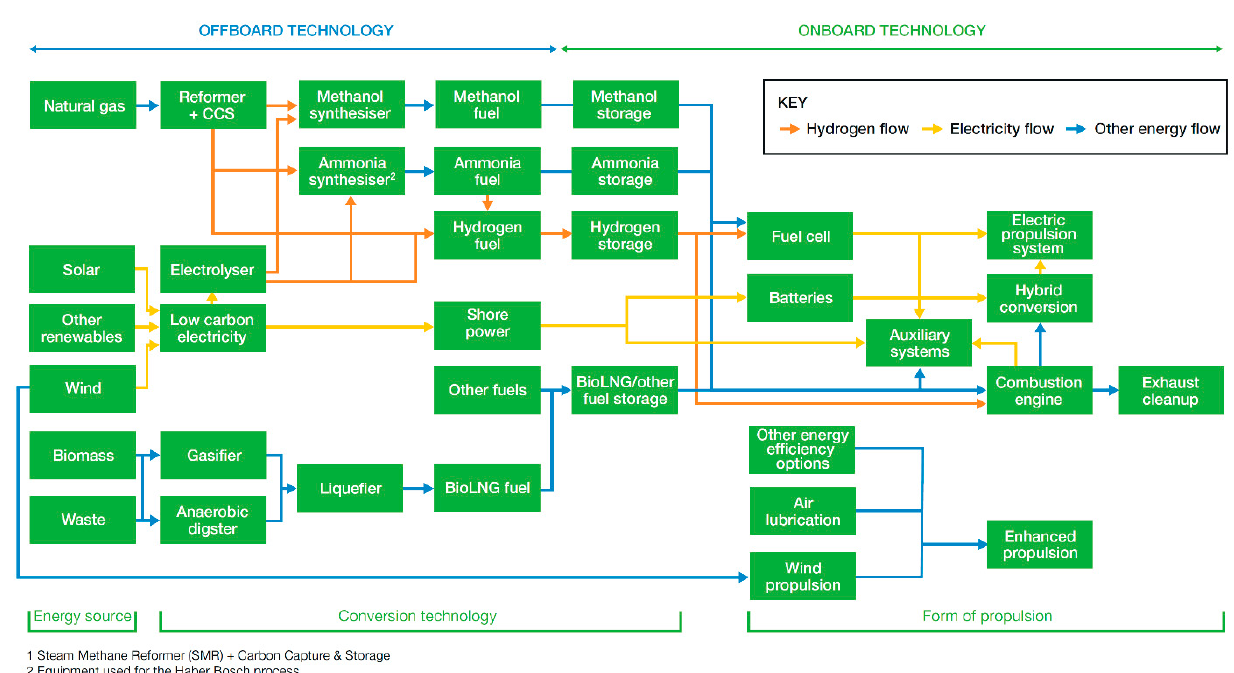
Figure 2. Technologies and fuels on a pathway to zero-emission shipping. Reproduced from [54], with permission from Department for Transport, 2019.